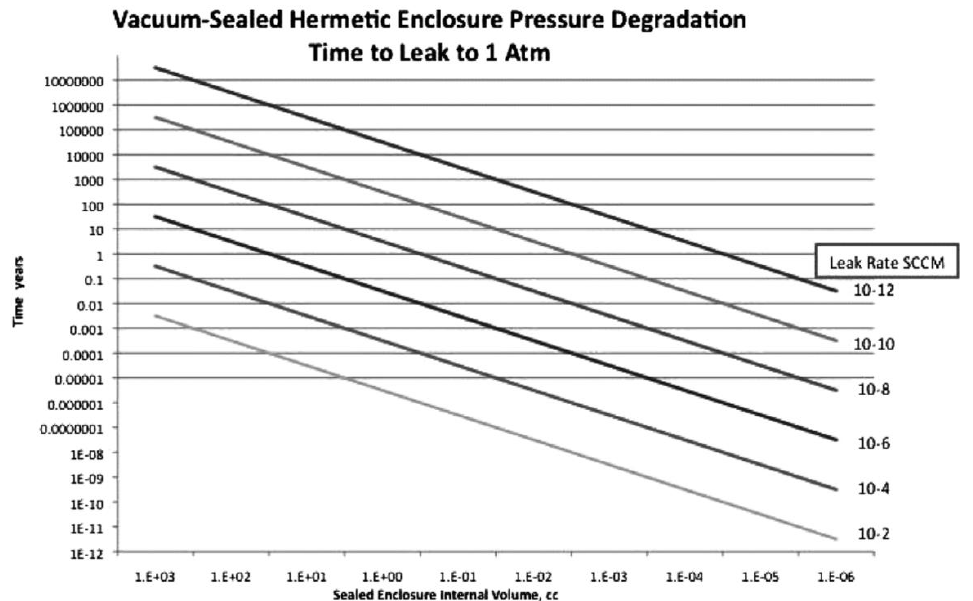
Figure 16. Relationship between the package volume, the leak rate, and the time for the pressure to rise to 1 atmosphere (atm). Small package volumes used in state-of-the-art sensors leak up to atmospheric pressure in seconds to minutes [17]. Reprinted with permission from the Society of Photo-optical Instrumentation Engineers (SPIE).